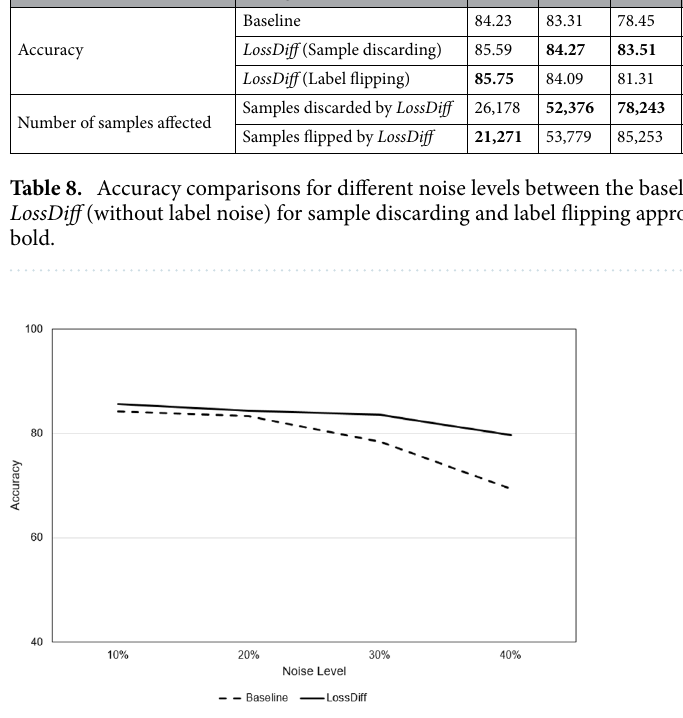
Figure 11. Accuracy comparison between baseline and LossDiff at different levels of noise.